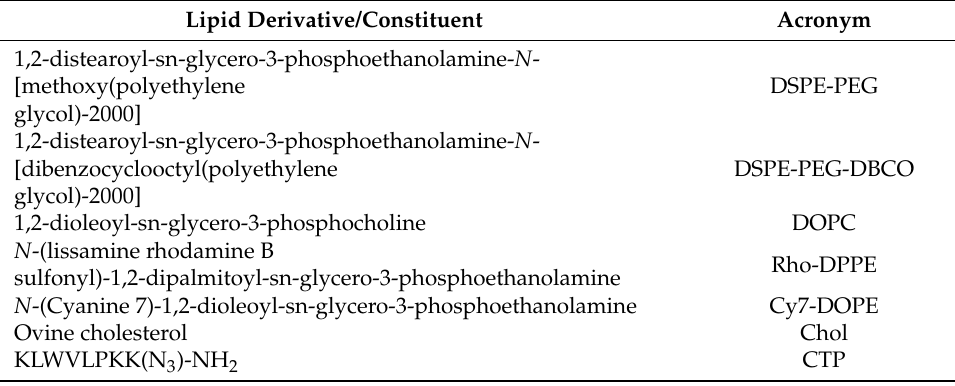
Table 1. Defined liposome constituent